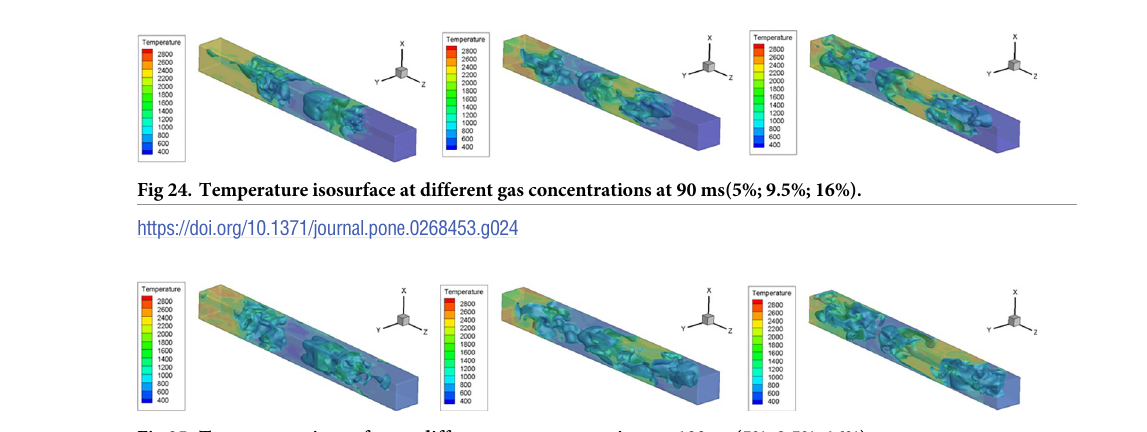
PLOS ONE | https://doi.org/10.1371/journal.pone.0268453 May 26,